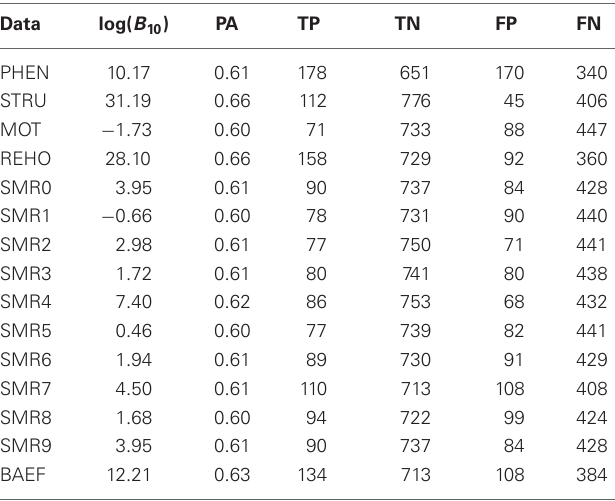
Table 3 | Single source standard k -fold